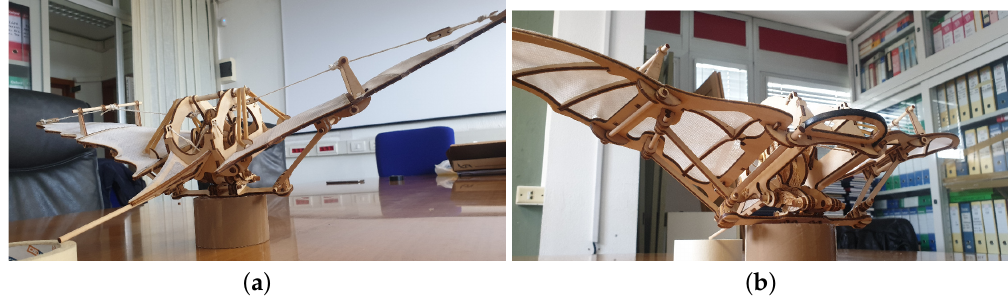
Figure 8. Leonardo Flying machine: ( a ) rear view; ( b ) front view.